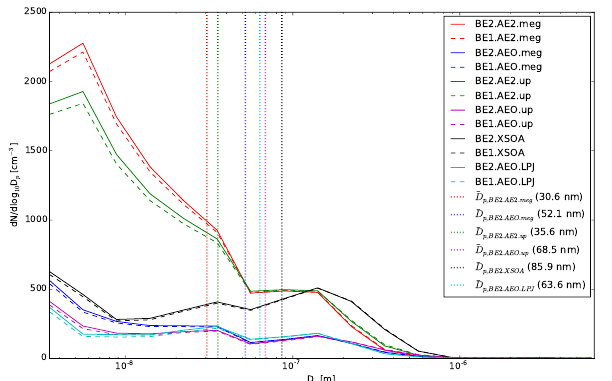
Figure 7. Simulated global boundary layer annual-mean par- ticle number size distributions for the simulations outlined in Table 1. The vertical dotted lines represent the mean di- ameter for the simulations using year 2000 biogenic emis- sions (BE2.AE2.meg, BE2.AEO.meg, BE2.AE2.up, BE2.AEO.up, BE2.XSOA, and